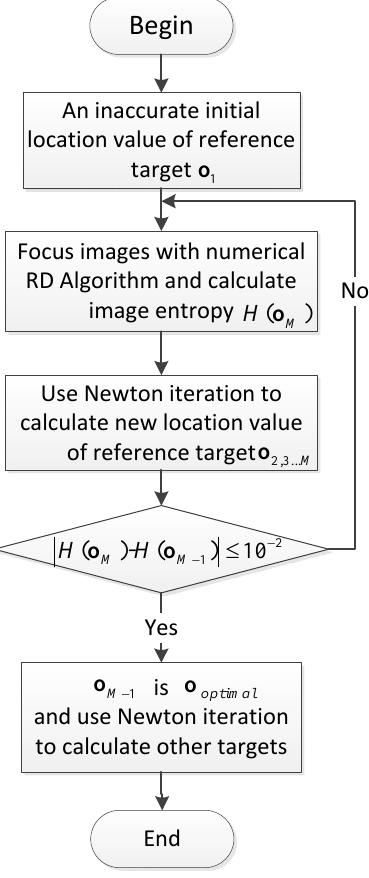
Figure 9. Flowchart of the three-dimensional localization